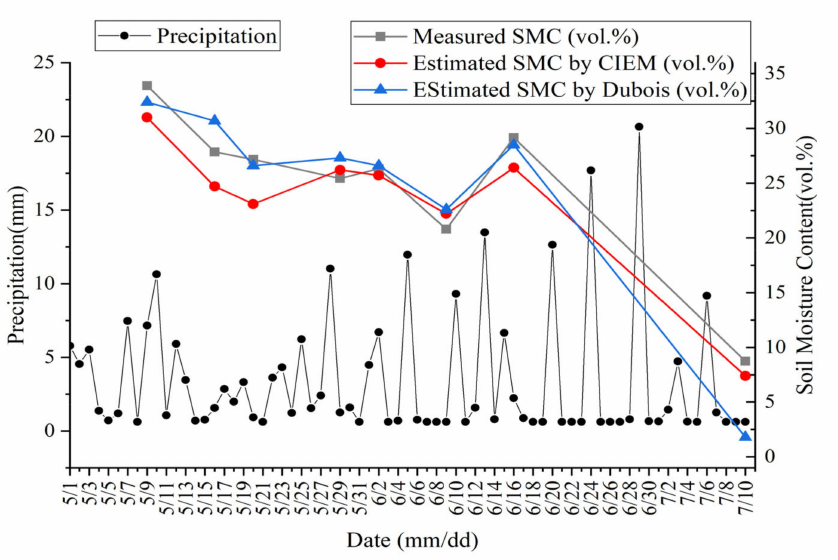
Figure 10. Dynamics of daily precipitation and mean